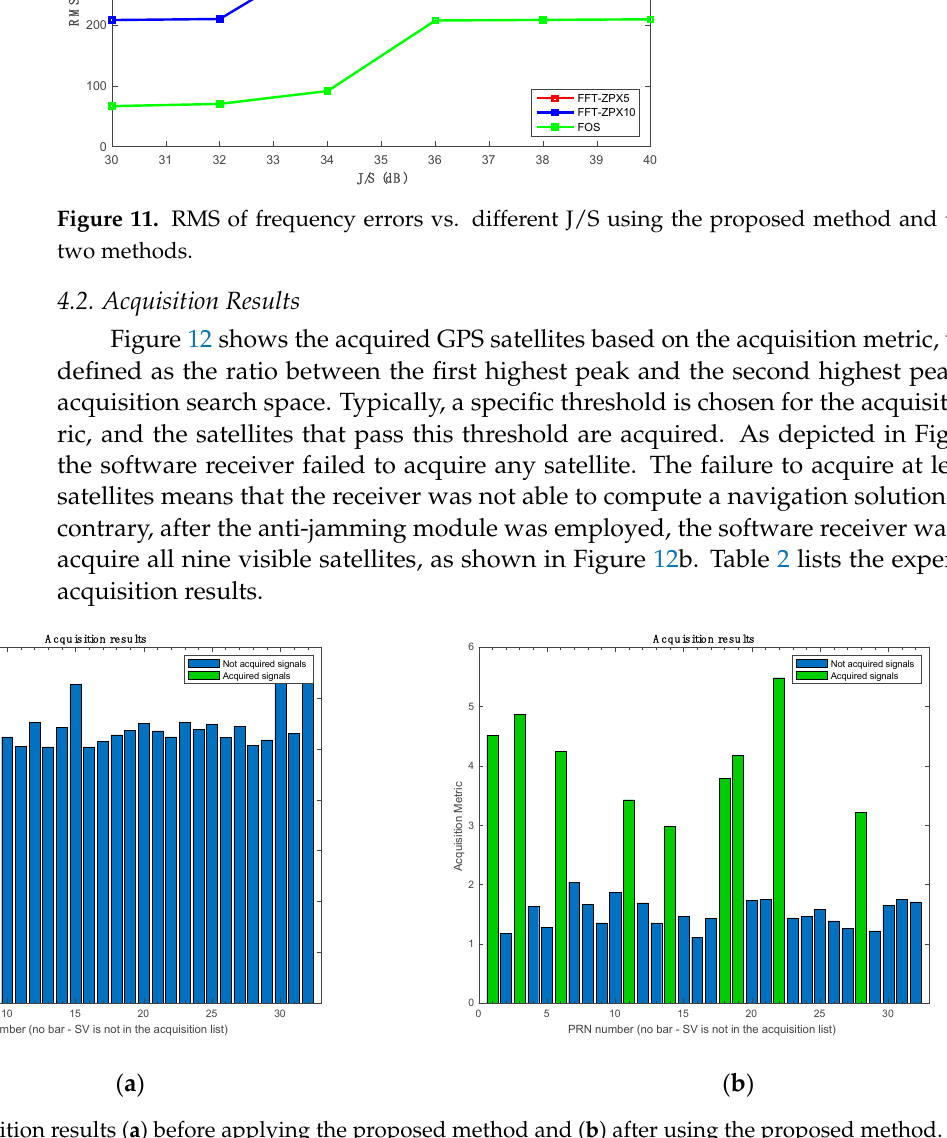
Figure 12. Acquisition results ( a ) before applying the proposed method and ( b ) after using the proposed method. Table 2. Summary of the acquisition results.